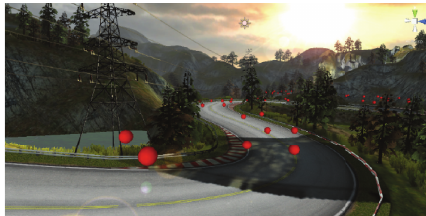
Figure 1: Waypoints at key positions on the racetrack are shown as (red)